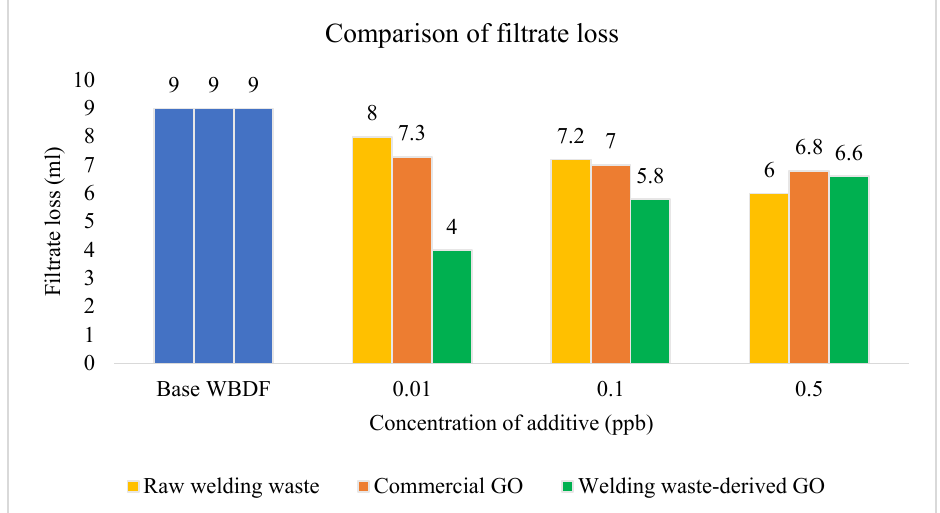
Figure 10. FL comparison of WBDF using different additives.